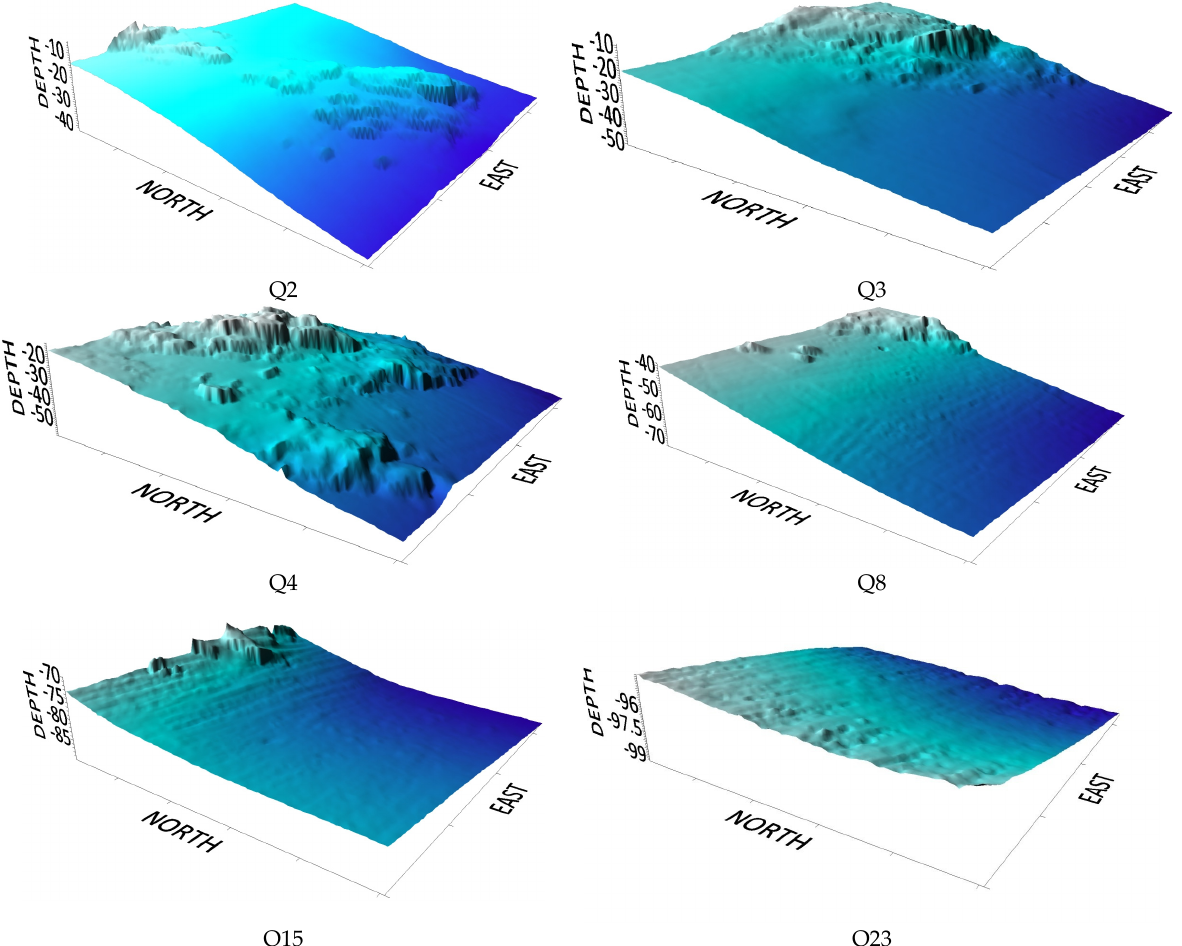
Figure 5. 3D representation of the di ff erent sectors selected to investigate the factor seabed morpho- logical complexity.